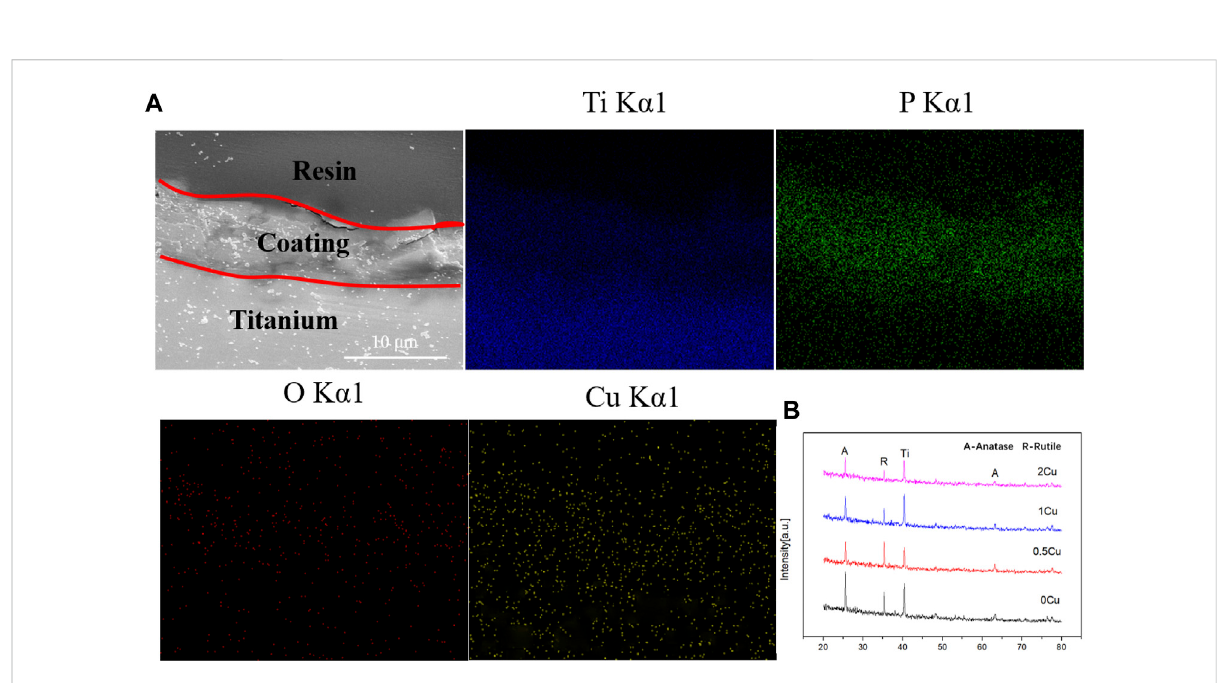
FIGURE 3 Cross-sectional backscattered electron morphology and elemental distributions of the 1Cu-MAO coating (A) . XRD patterns of 0Cu-MAO, 0.5Cu-MAO, 1Cu-MAO and 2Cu-MAOcoatings (B) .